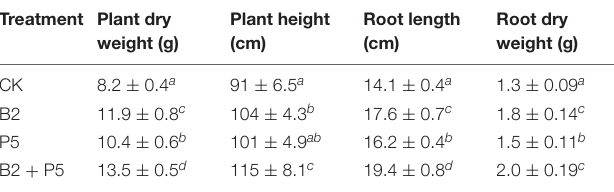
TABLE 3 | Effects of four treatments on cucumber plant growth (60 days after